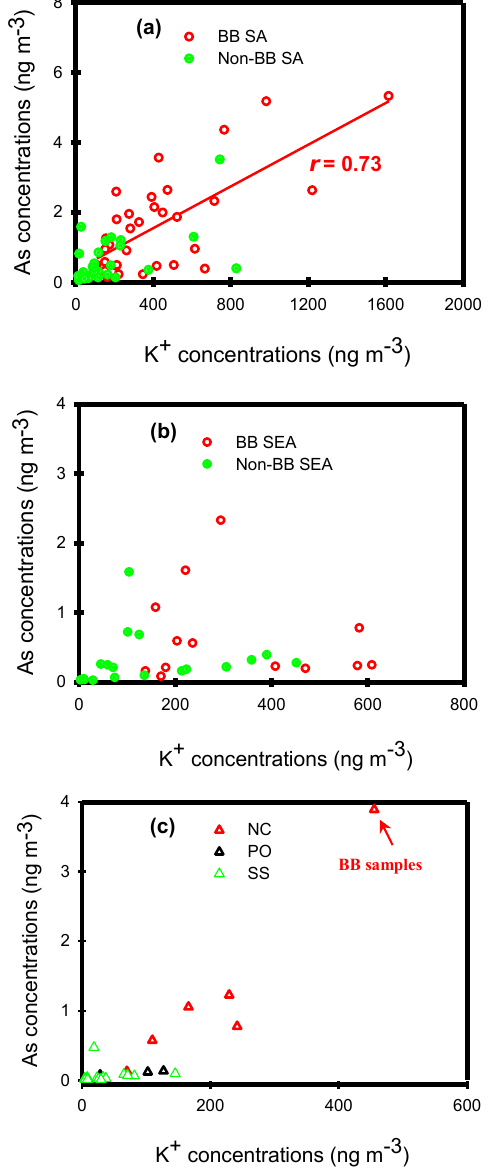
Figure 8. Scattered plots of As against K + observed at Mount Hehuan in (a) SA, (b) SEA, and (c) other air groups during the S and SE Asian biomass burning